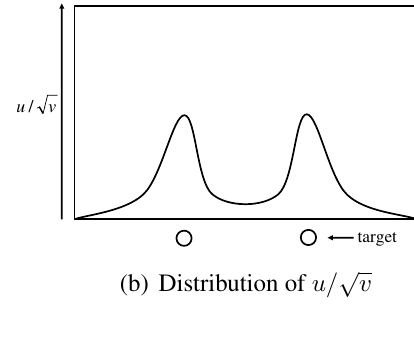
√ v with closely located targets.